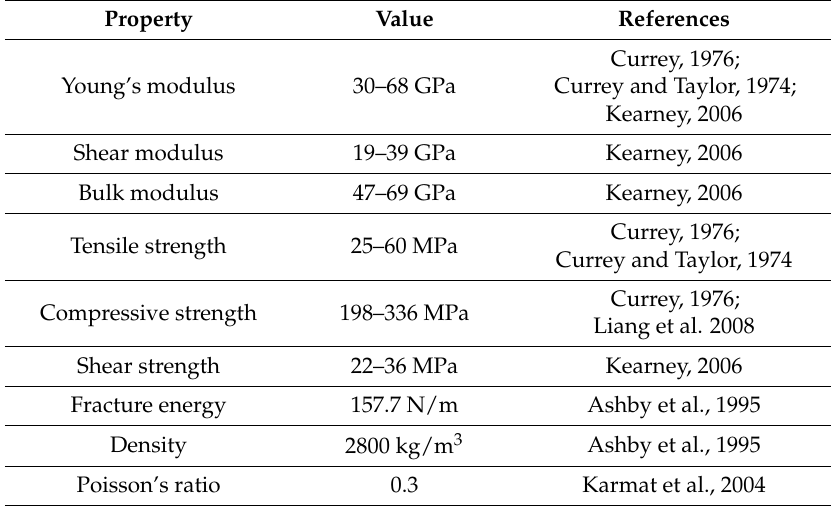
Table 1. Mechanical properties of O. lactea (summarized from Reference [26]).